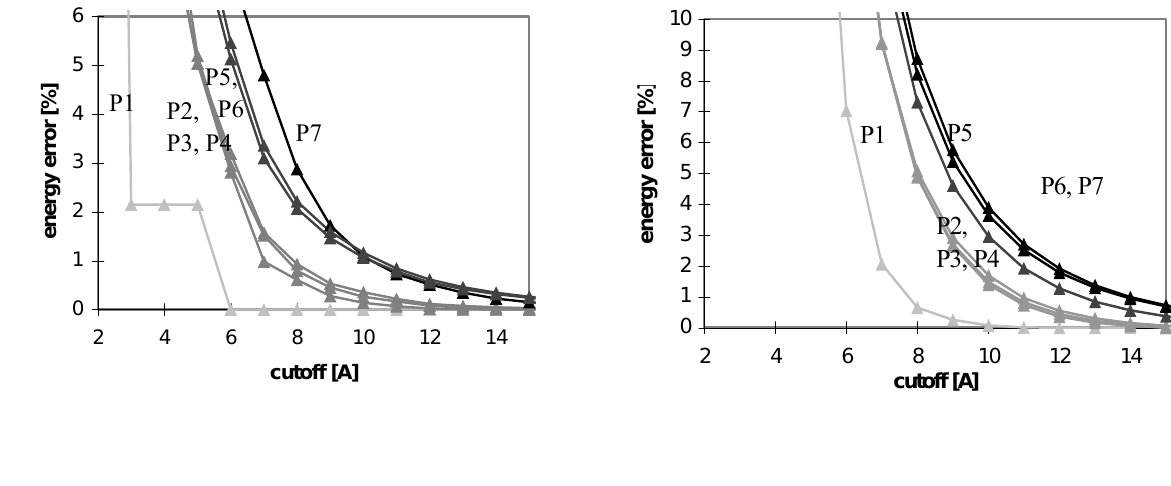
Figure 2 . Dependency of Evdw error on cutoff (for both cutoff (left) and PME (right) methods for all studied peptides and proteins, the darker color of the curve, the larger the molecule is). For description of energy error see Figure 1.